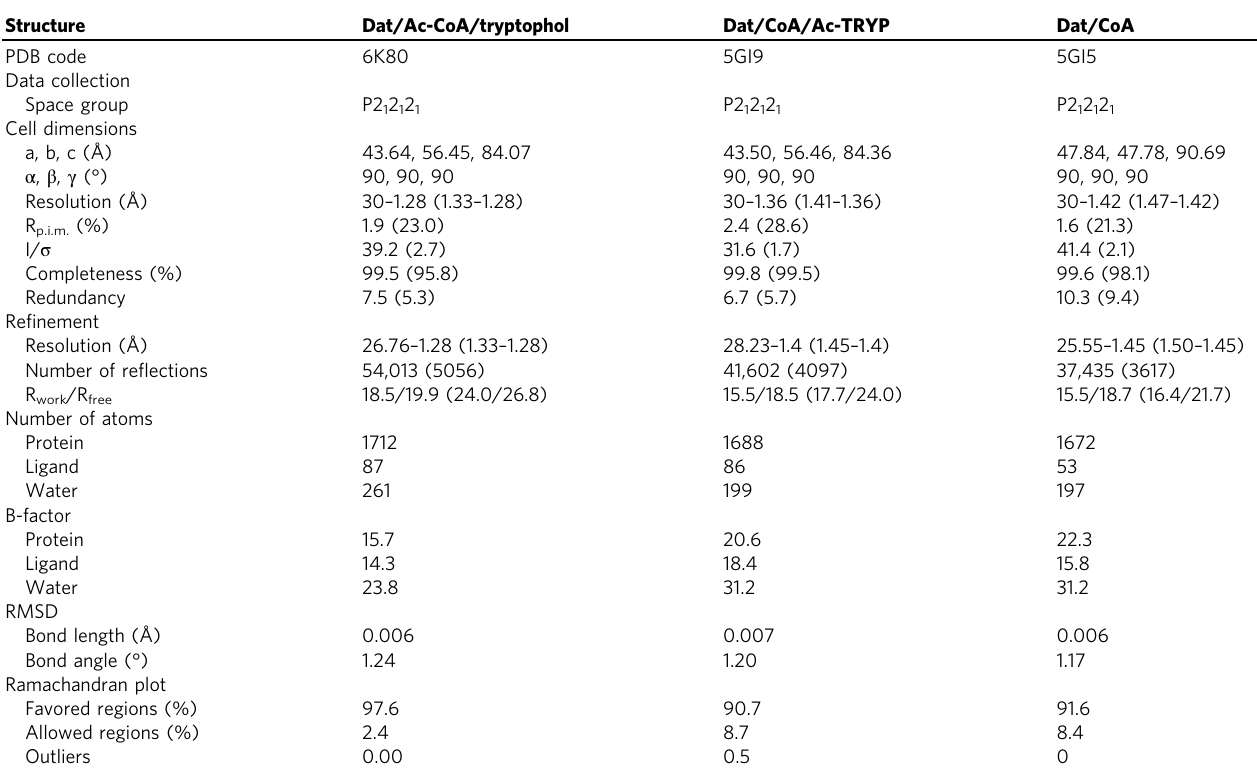
Table 1 Data collection and re fi nement statistics of the complex structures of